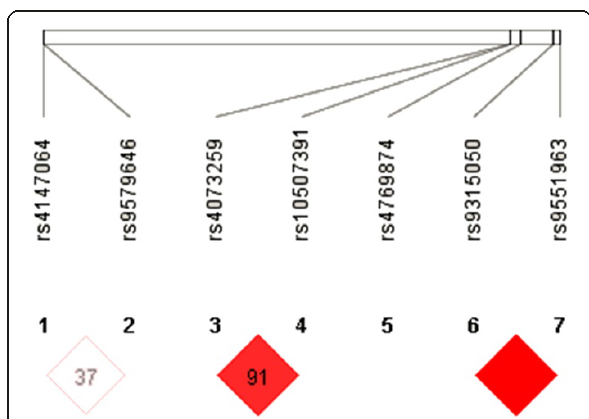
Figure 1 Analysis of haplotype distribution between ischemic stroke patients and controls. Linkage was found to be significant between rs9315050 vs. rs9551963, rs4073259 vs. rs10507391, and rs9579646 vs. rs4147064 (D ’ =1.0, D ’ =0.911, and D ’ =0.376,